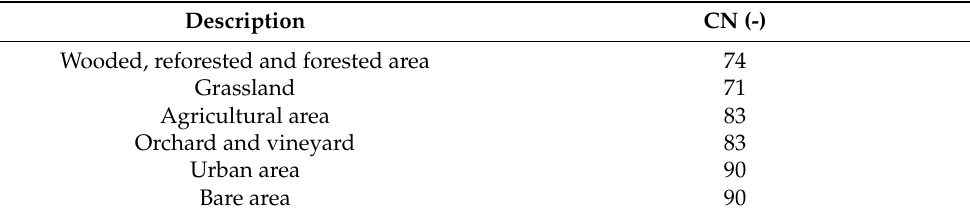
Table 2. CN values in the Guerna creek basin. Description CN (-) Wooded, reforested and forested area 74 Grassland 71 Agricultural area 83 Orchard and vineyard 83 Urban area 90 Bare area